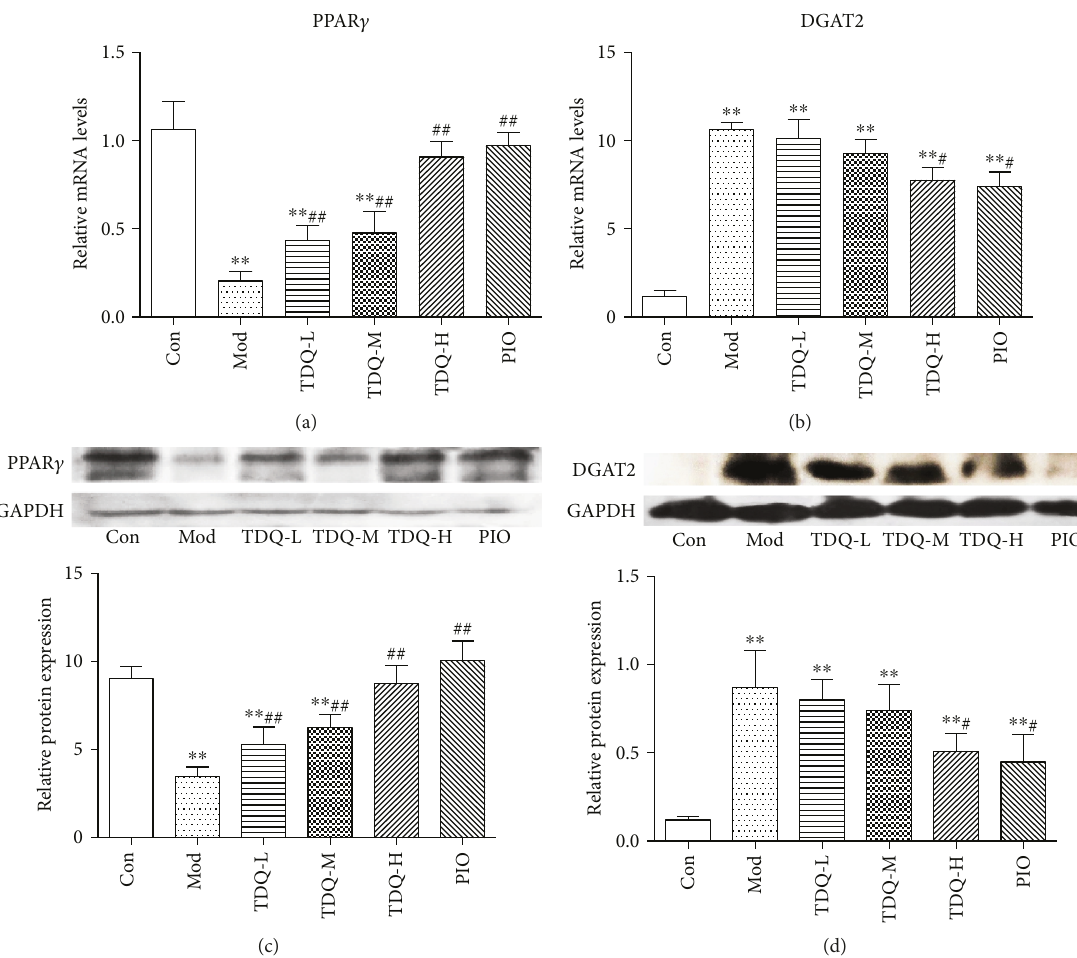
Figure 3: PPAR γ and DGAT2 play crucial roles in high-fat diet and STZ-mediated insulin resistance and abnormal lipid metabolism diabetic model. (a, b) qRT-PCR analysis of mRNA levels of PPAR γ and DGAT2. (c, d) Western blotting showing PPAR γ and DGAT2 protein expression in liver and quantitative analysis of protein expression relative to GAPDH. Data are presented as the mean ± SD . ∗ P < 0 05 and ∗∗ P < 0 01 vs. Con; # P < 0 05 and ## P < 0 01 vs.